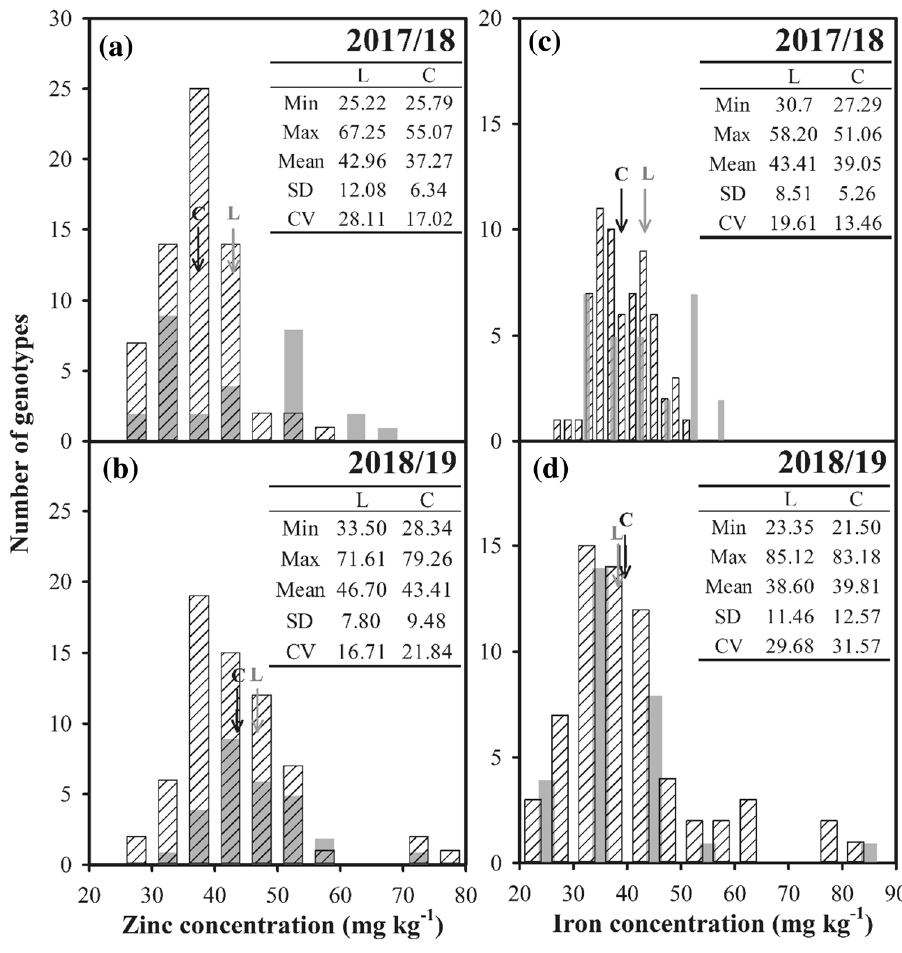
Figure 2. Frequency distribution of grain ( a,b ) zinc and ( c,d ) iron concentrations of the ninety-three wheat accessions in the Experiment I. The landraces are marked in grey. Arrows indicate mean values of ( L ) landrace and ( C )